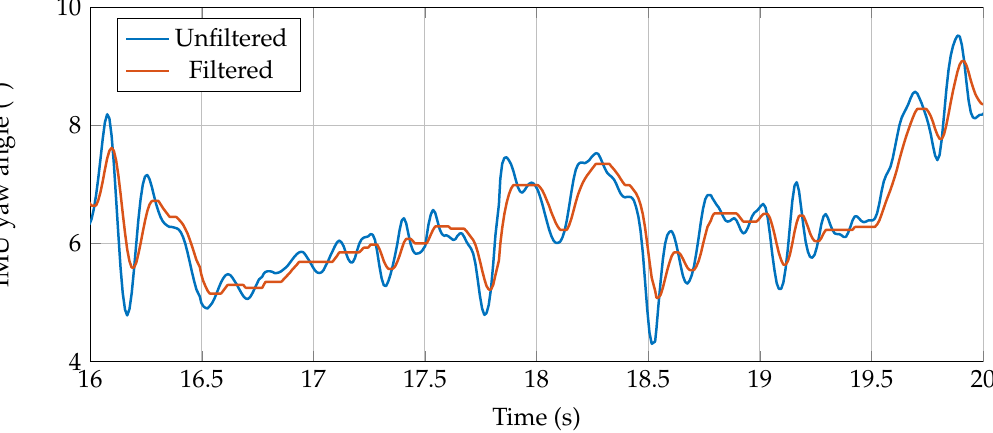
Figure 10. The moving average filter smoothens angle measurement (here yaw), but also adds a slight delay. The additional deadband suppresses angle variations below the specified threshold, which results in short segments of constant yaw angle.